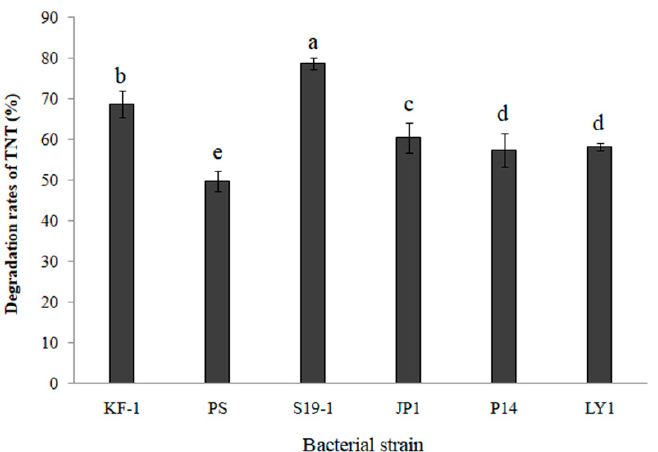
Figure 1. TNT was degraded by six selected bacteria. Each bacteria culture at optical density (OD 600nm = 0.1) was exposed to TNT (15 µL of 0.1 mg/mL) and cultured for 9 h at 27 °C (see Mater als and Methods for a full description of bacterial strains). Each data point represents N = 4, x ± SD. Statistical significance is denoted as p < 0.05 using a statistical program for social sciences (SPSS 24.0, IBM, USA, 2016).